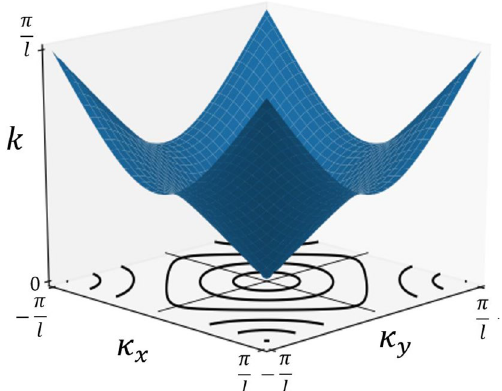
Figure 4. The band diagram for a lattice without resonant elements. Shown are iso-frequency contours for various values of k in the κ x , κ y